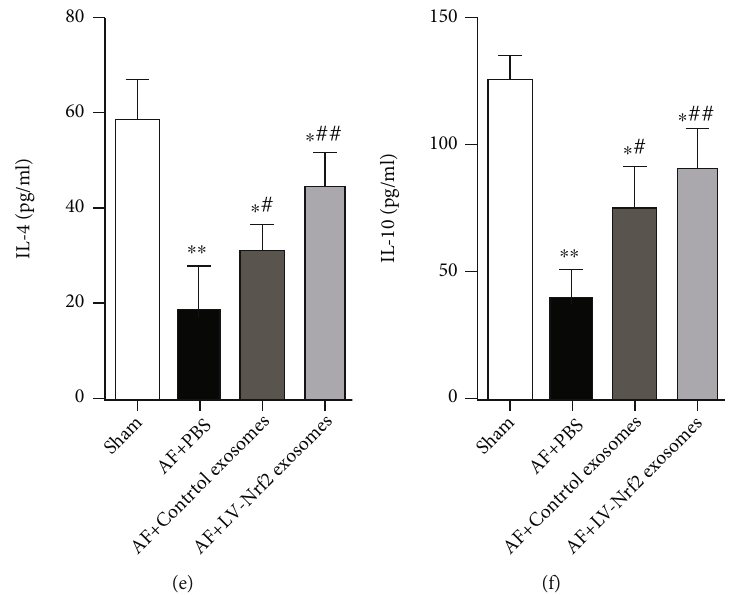
Figure 5: Lv-Nrf2 exosome treatment decreased apoptotic cells and in fl ammation in myocardial tissue of AF rats. (a, b) The degree of apoptosis in rat myocardia for every group was con fi rmed through TUNEL staining and quantitative analysis; scale bar = 100 μ m . (c – f) TNF- α , IL-1 β , IL-4, or IL-10 expression in the rat serum was assessed via ELISA. n = 5 in each group. Results re fl ected mean ± SD . ∗ P < 0 : 05 , ∗∗ P < 0 : 01 in comparison to the control group. # P < 0 : 05 , ## P < 0 : 01 in comparison to the AF+PBS